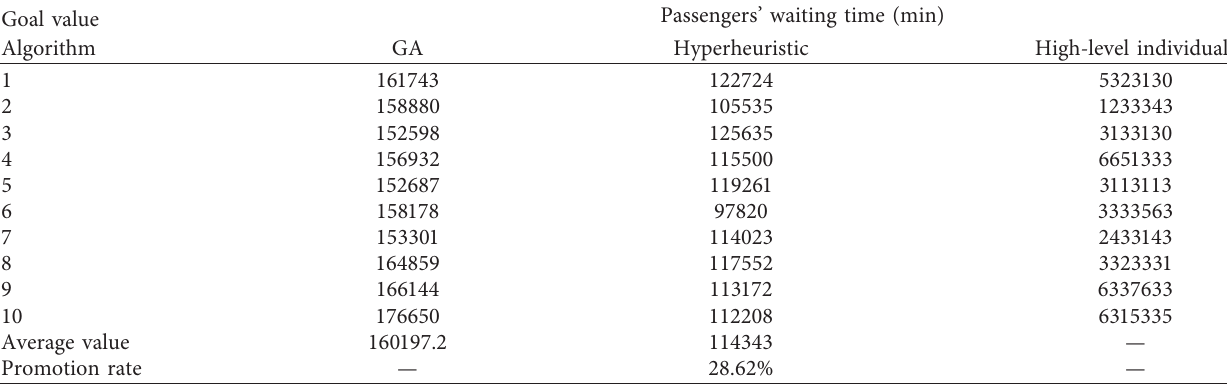
Table 7: Results of GA and hyperheuristics algorithm under multisection convex passenger